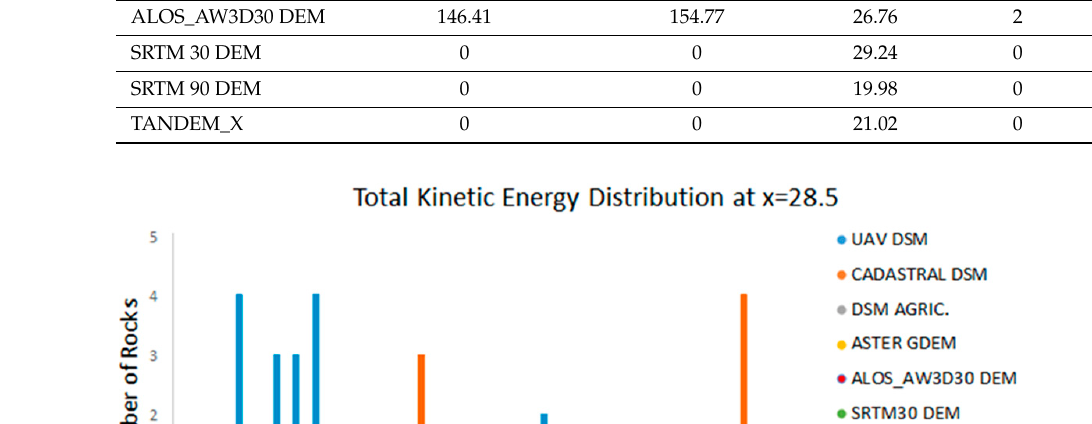
Table 10. Total kinetic energy distribution at x = 28.5 m for the 2nd slope profile.